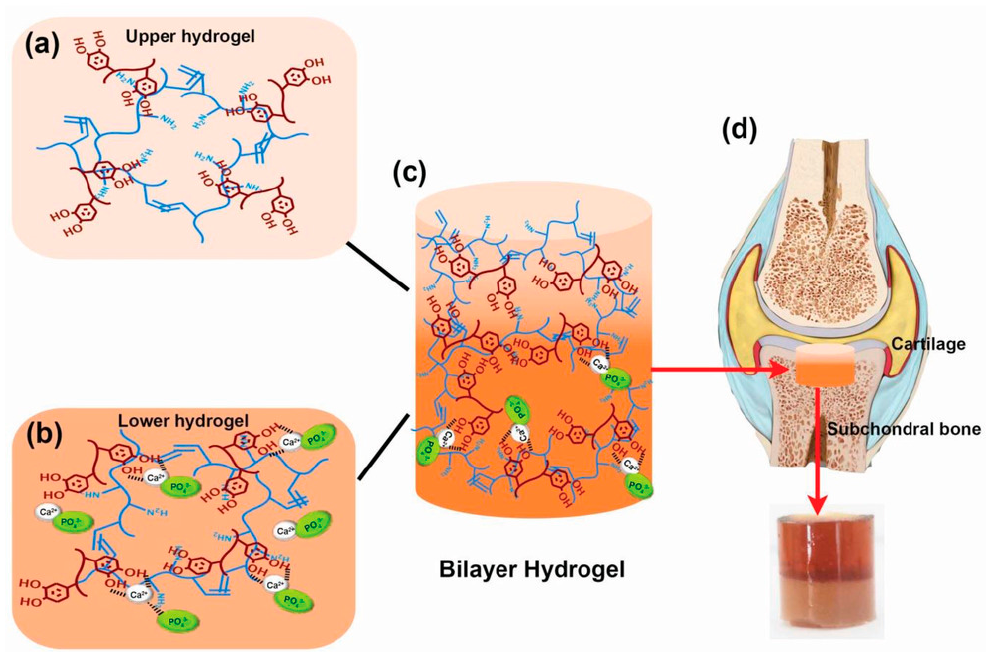
Figure 7. ( a ) The upper hydrogel layer for cartilage defect repair was prepared by mixing Gelatin methacryloyl (GelMA) with polydopamine (PDA) ( b ) The prepared lower layer hydrogel for subchondral bone repair was prepared by mixing Ca 2 + -GelMA with PO 43 − -GelMA to generate hydroxyapatite (HA). ( c ) Combination of these two hydrogels to form the final structure of the hydrogel bilayer. ( d ) Illustration of the application of the hydrogel bilayer for the bone defect repair. Reprinted with permission from reference [71]. Copyright © 2019 WILEY-VCH